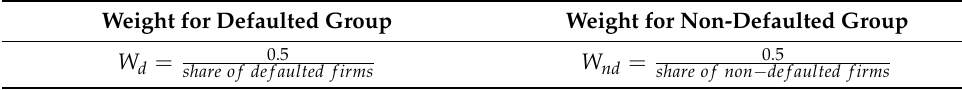
Table 4. Formulas to calculate weights. Weight for Defaulted Group Weight for Non-Defaulted Group W d